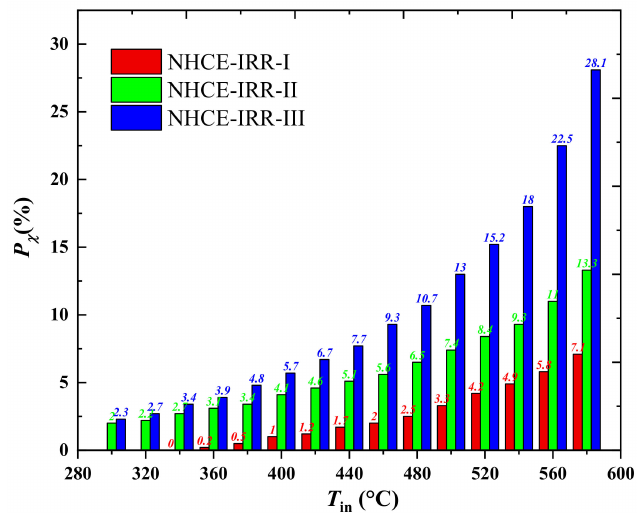
Figure 10. Percentage of exergetic e ffi ciency enhancement of NHCEs versus inlet temperature.